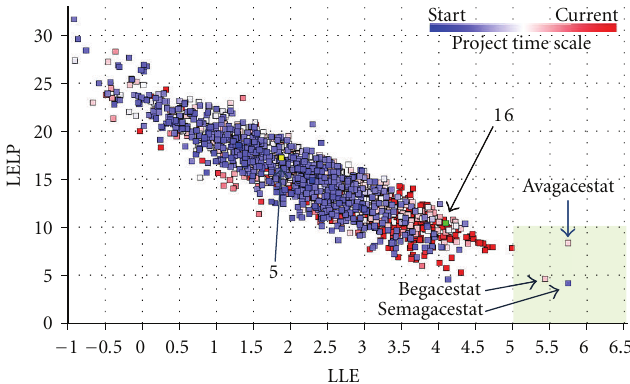
Figure 5: Evolution of our non-acid GSM series in relation to lipophilic e ffi ciency parameters LELP and LLE. (a) LELP and LLE were calculated as described in Section 2. The highlighted section (LELP < 10, LLE > 5) indicates the desired area for drug-like compounds [35]. Each square indicates a compound, with the colour being indicative for when the compound has been synthesized during the project.